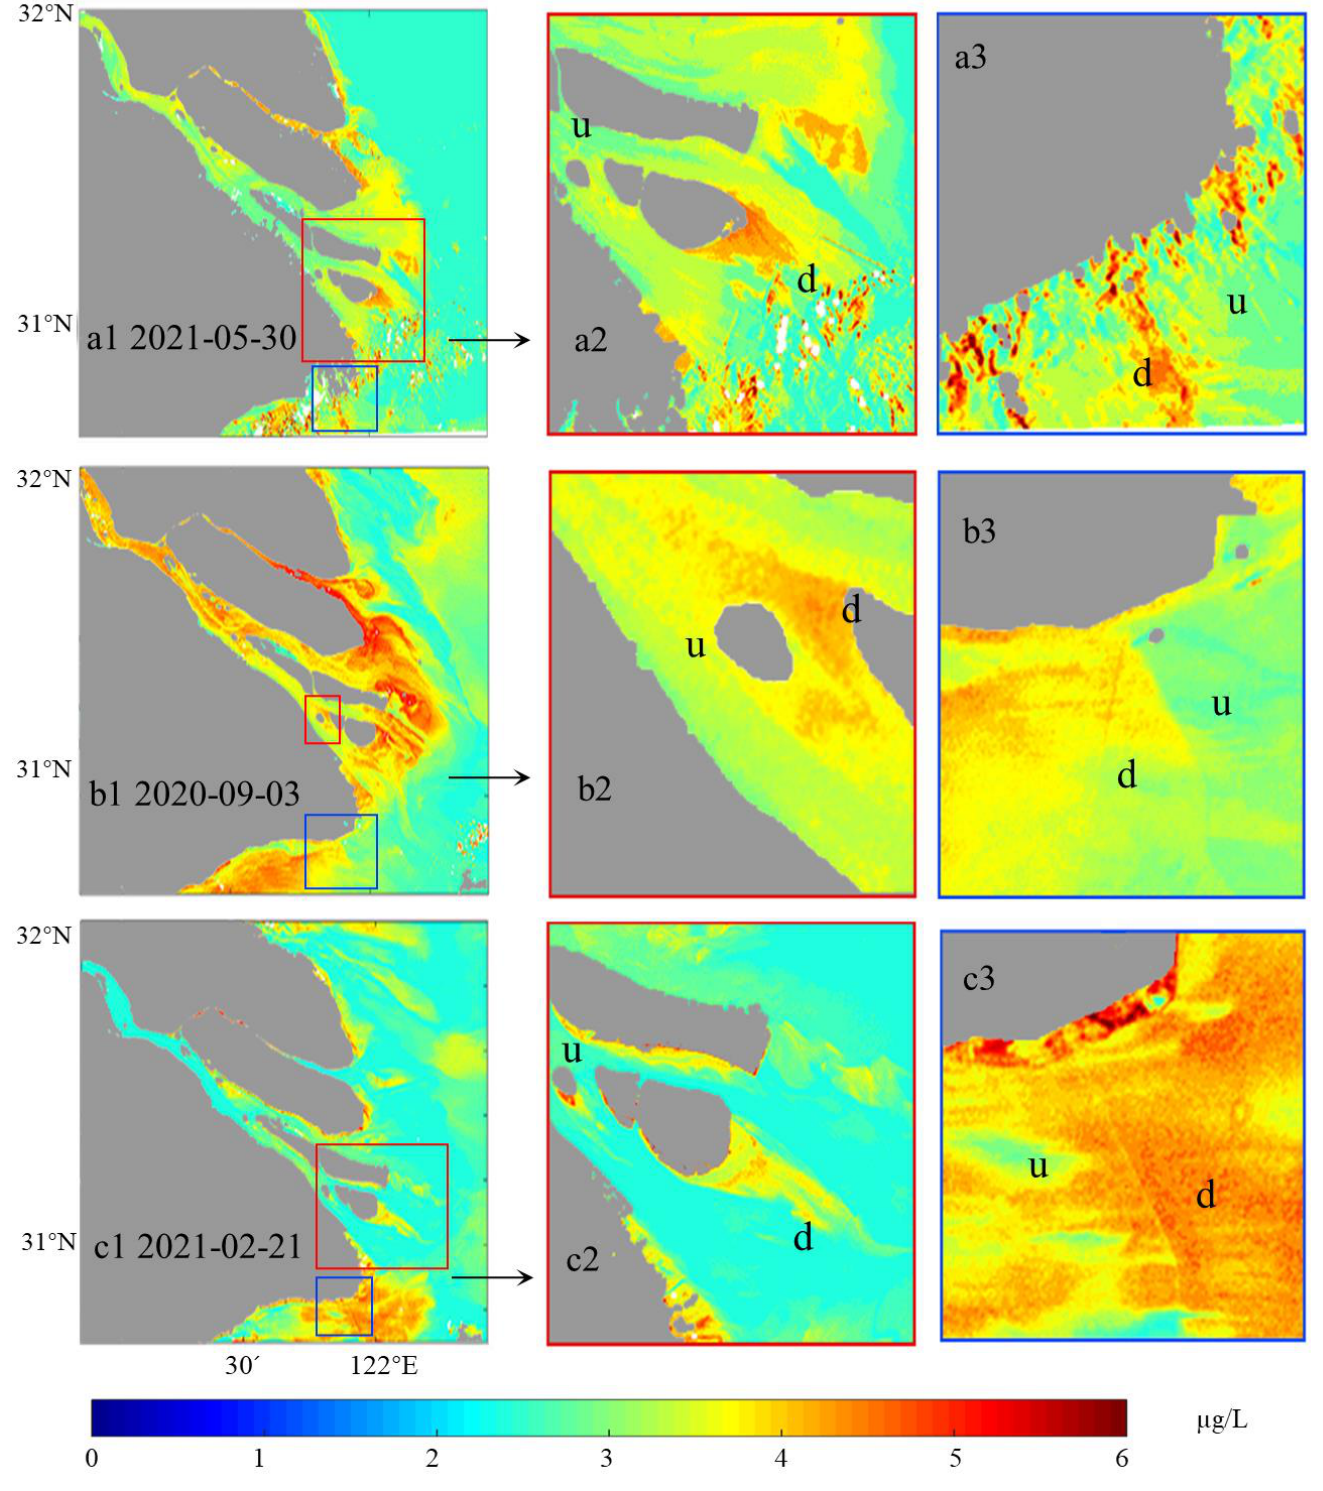
Figure 5. ( a1 – c1 ): Chl-a concentration retrieved from GF-4. Colored squares: Chl-a concentration distribution in the area near islands and bridge; ( a2 – c2 ): the red squares; ( a3 – c3 ): the blue squares; u: upstream; d: downstream.